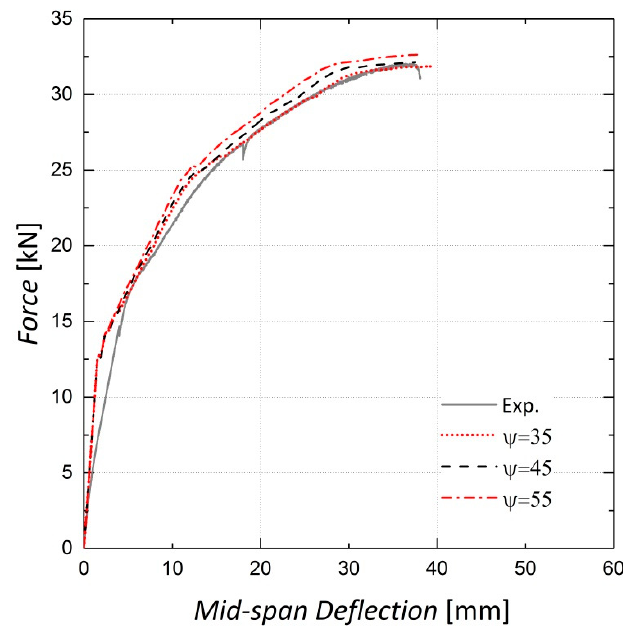
Figure 13. Sensitivity of results to dilation angle—Beam 11.